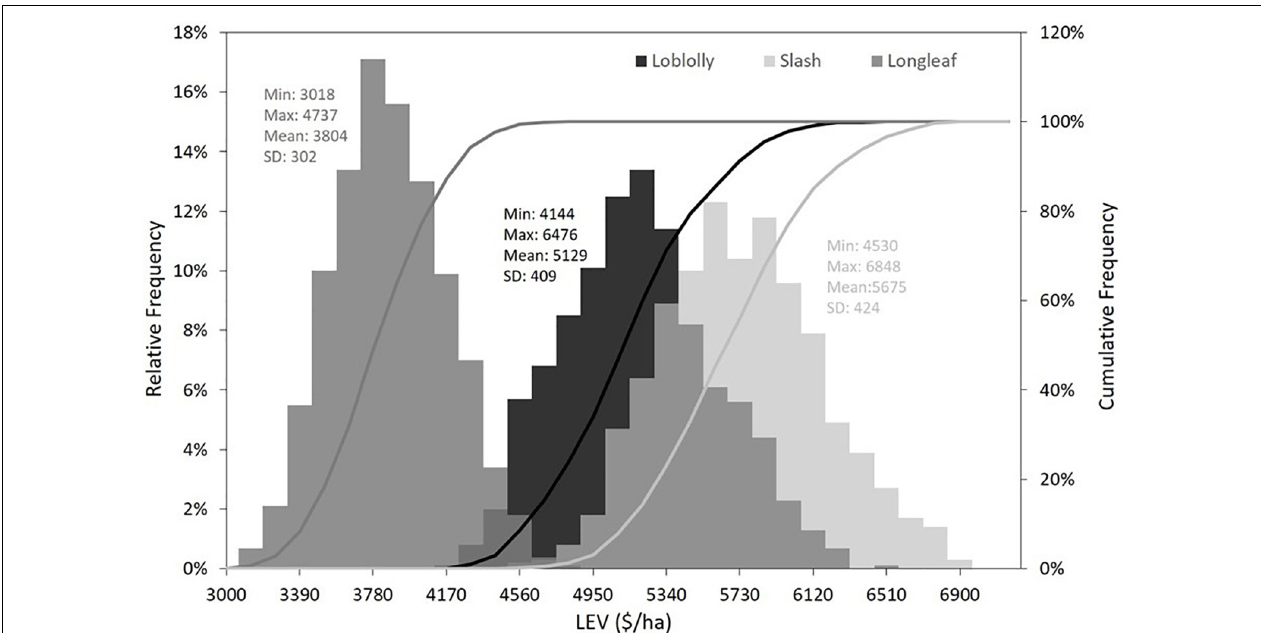
FIGURE 5 | Relative distribution and cumulative frequency distribution of simulated LEVs of loblolly, slash, and longleaf